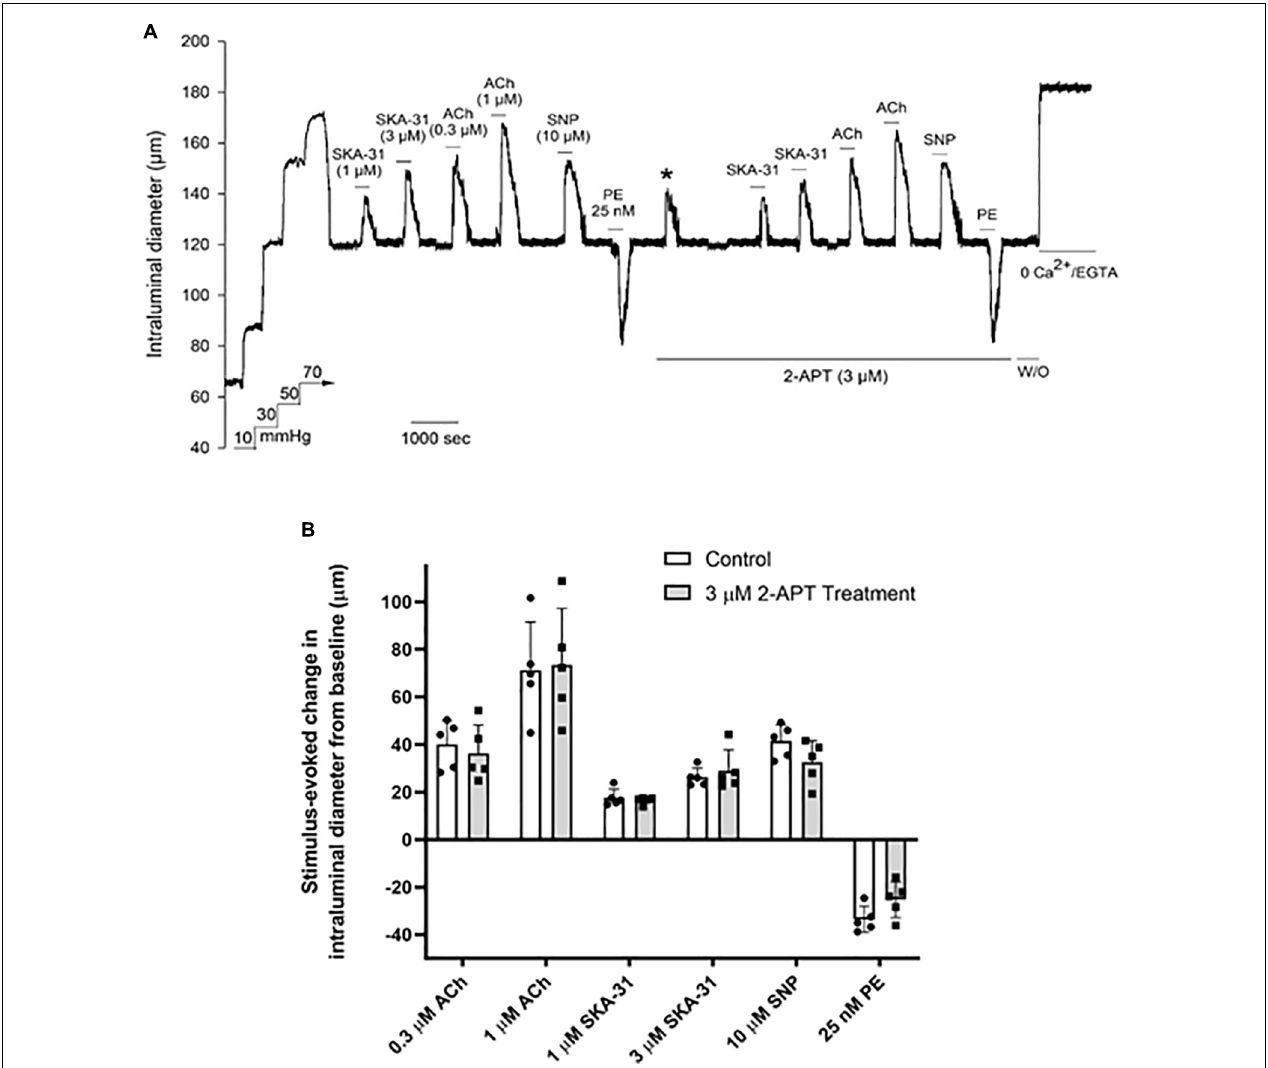
FIGURE 4 | The selective NOX1 inhibitor 2-APT does not modify vasoactive responses in cremaster arteries from adult Sprague–Dawley rats. The representative tracing in panel (A) shows the effects of endothelium-dependent and -independent vasoactive agents in the absence and presence of 3 µ M 2-acetylphenothiazine (2-APT). Compounds were present in the bath as indicated by the horizontal bars above and below the tracing. The asterisk above the tracing denotes a transient dilatory response that was typically observed following bath addition of 3 µ M 2-APT. Maximal arterial diameter was determined at the end of the protocol by addition of nominally Ca 2 + free physiological saline solution (i.e., 0 added CaCl 2 + 2 mM EGTA). The histogram in panel (B) quantifies the absolute changes in intraluminal diameter evoked by each vasoactive agent in the absence and presence of 3 µ M 2-APT treatment ( n = 5). Data are presented as means ±